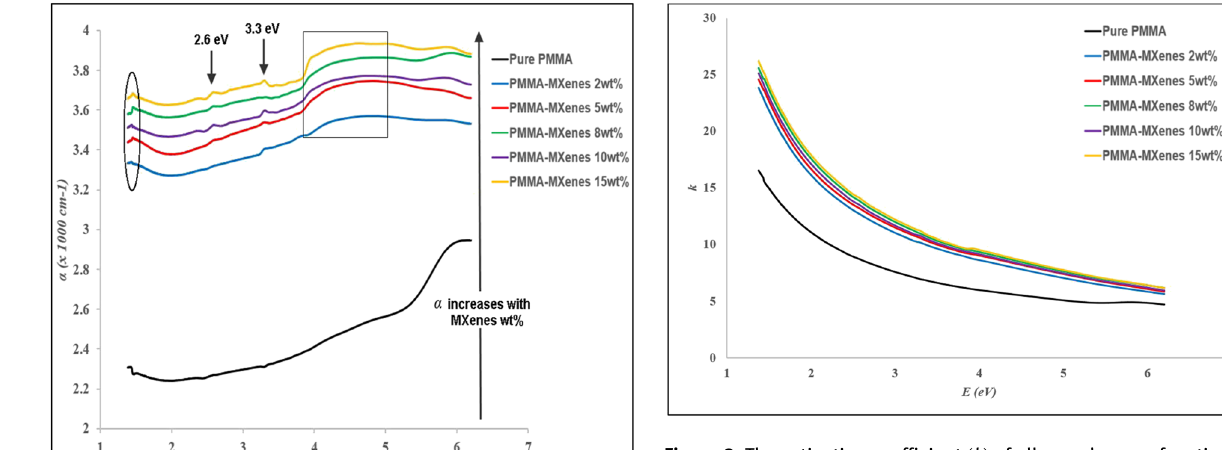
Figure 8: The extinction coe ffi cient ( k ) of all samples as a function of photon energy ( E